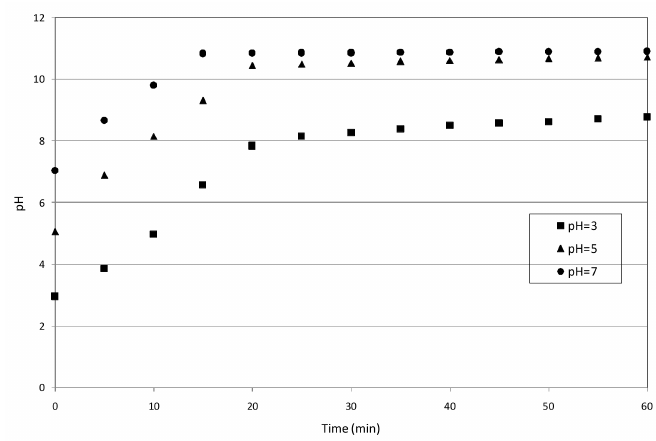
Figure 8. pH trends during the tests conducted with MgO_nZVI and initial Pb 2+ concentration of 30 mg/L.